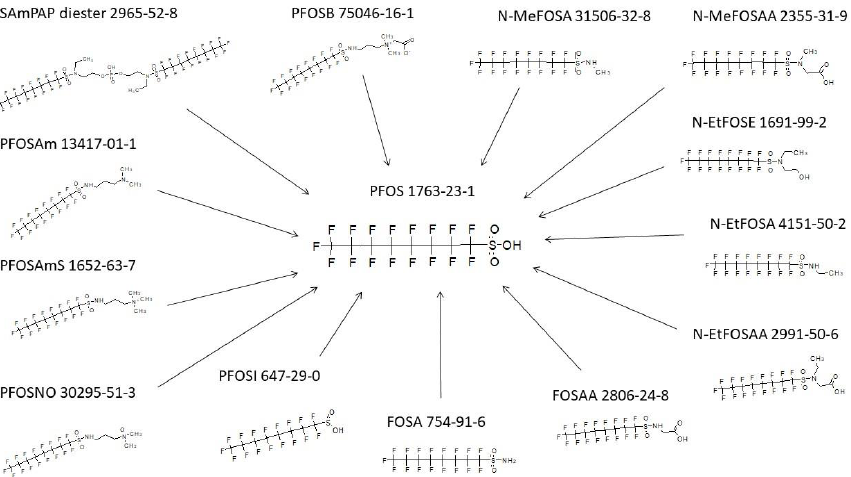
Figure 2. PFOS originating from a very diverse set of parent structures as found in the database.